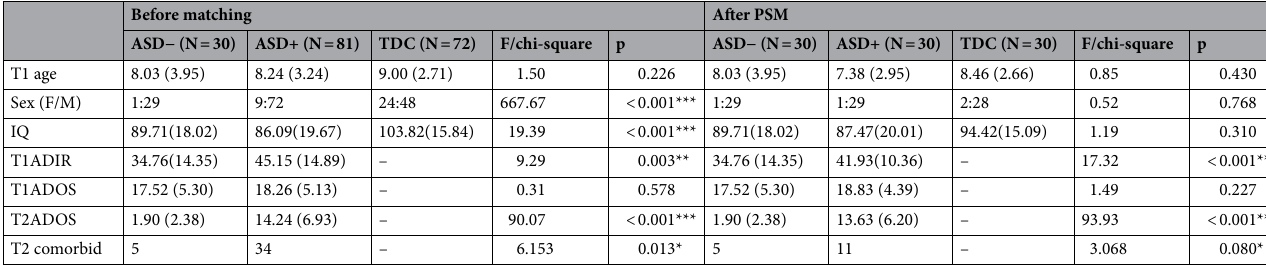
Table 1. Demographics characteristics of participants before and after propensity score matching. *p < 0.05; **p < 0.01; ***p < 0.001. ASD− ASD with optimal outcome, ASD+ ASD with persistent symptoms, TDC